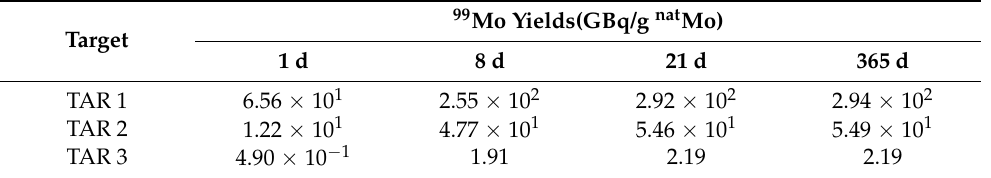
Table 5. 99 Mo yields of nat Mo at various irradiation times